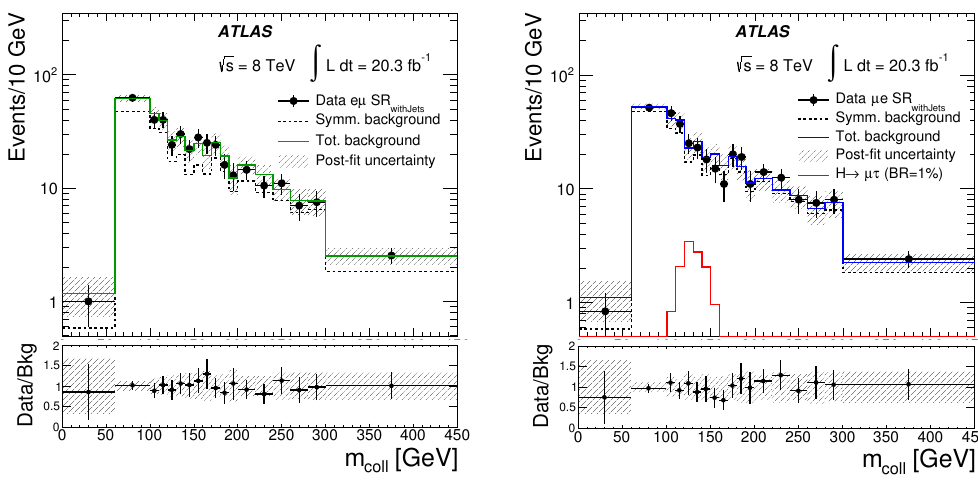
Figure 2: The distribution of the reconstructed di-tau mass in the H → e τ (left) and H → µτ (right) searches in a signal region including jets [ 11 ] . The signal is shown only for the H → µτ process. The lower panels quantify the agreement between data and background